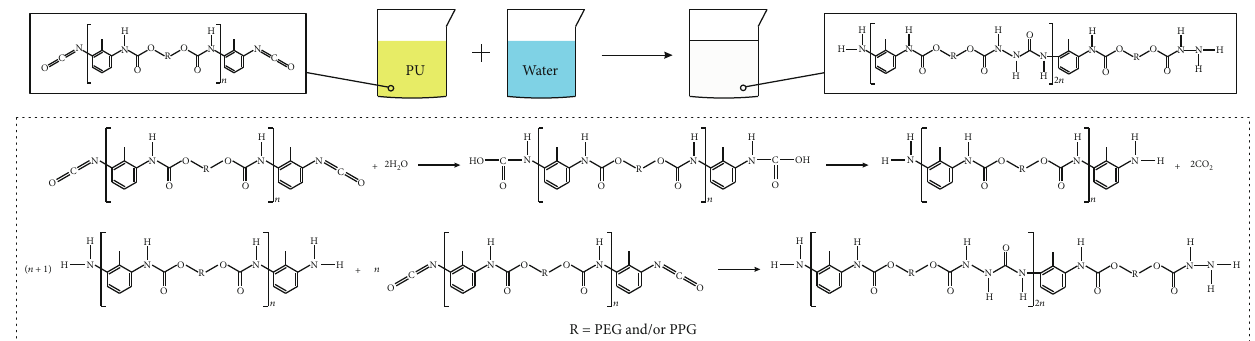
Figure 12: The process of the reaction of polyurethane with water.